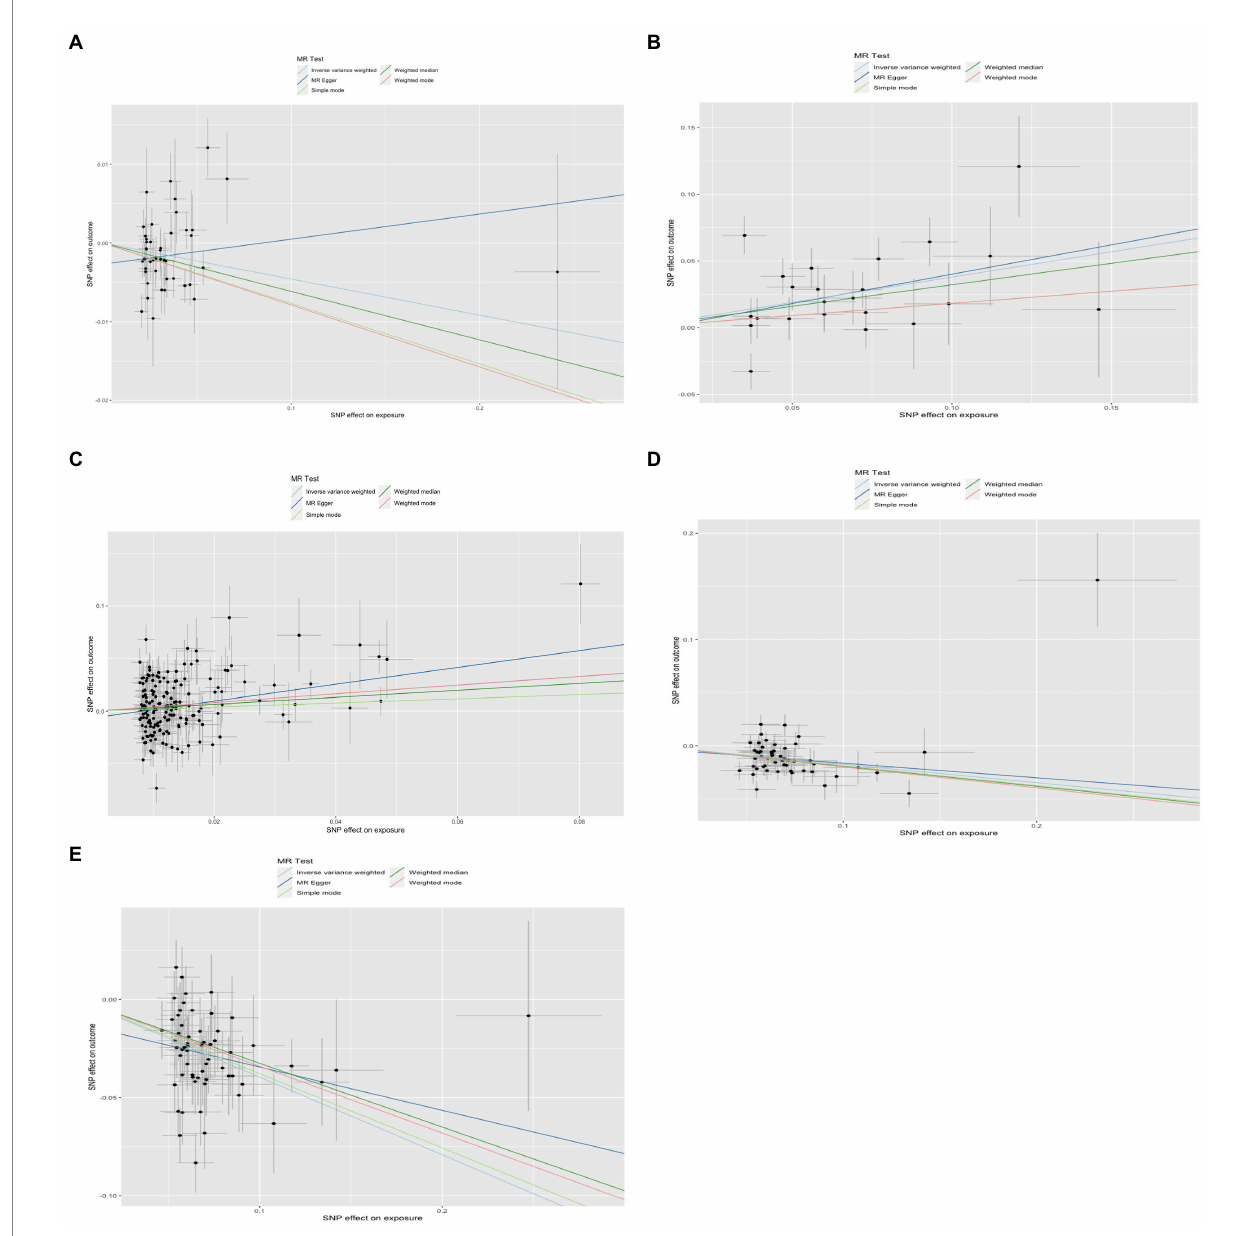
FIGURE 2 Results of the scatterplot. (A) Lower birth weight (BW)-Alzheimer’s disease (AD); (B) childhood body mass index (BMI)-attention-deficit hyperactivity disorder (ADHD); (C) early life body size-ADHD; (D) age at first birth (AFB)-major depressive disorder (MDD); (E) AFB-ADHD; the solid dot means the causal effects of exposure on outcomes with four methods [MR-Egger (MRE); weighted median (WM); weighted mode (Wm); inverse-variance weighting (IVW); MR-Egger and Mendelian Randomization Pleiotropy RESidual Sum and Outlier (MR-PRESSO)]. The results of the binary outcomes are shown by OR [95%CI]. Numbers in bold mean P- values <5.00E-02, and italic and bold font means P- values